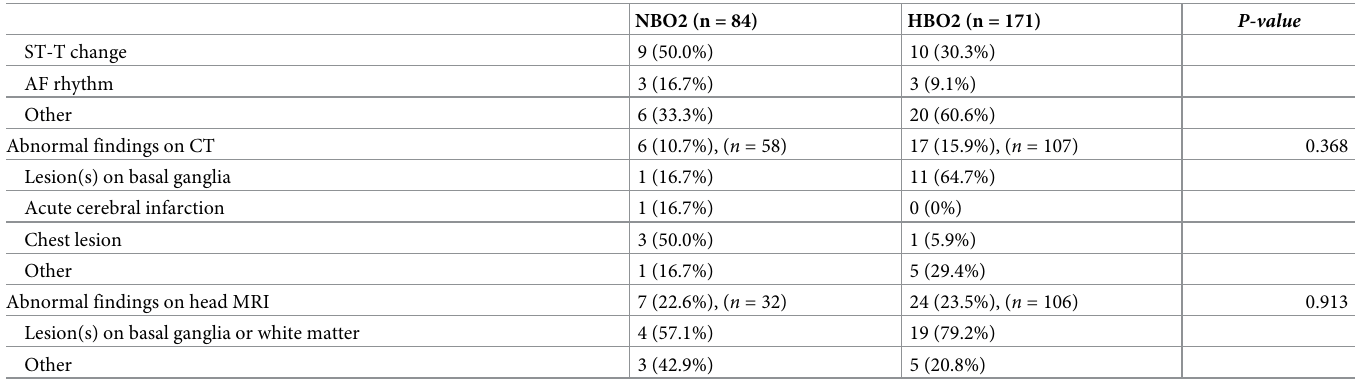
The treatment pressures in each HBO session during the first 24 h are shown in Table 2. 2 The treatment pressure in the first HBO session was 2.8 atmospheres absolute (ATA) (47.9% 2 of the HBO group), 2.0 ATA (41.8%), 2.5 ATA (7.9%), or another pressure (2.4%). A treat- 2 ment pressure of 2.0 ATA was used in the majority of patients in both the second and third HBO sessions. In addition, HBO therapy were not administered during the first 24 h in 2 2 2 patients of the HBO group and the details of HBO therapy were unknown in 4 patents. 2 2 The number of patients treated with mechanical ventilation was significantly more in the NBO group than in the HBO group (25.0% vs 4.7%, respectively, P < 0.001; Table 3). The 2 2 period of oxygen administration during the hospital stay was 344 ± 2128 h and 70 ± 190 h in the NBO and HBO groups, respectively, which did not differ significantly ( P = 0.266; 2 2 Table 3). ICU days was also significantly longer in the NBO group than in the HBO groups 2 2 (4.1 ± 11.0 and 1.3 ± 2.4 days, respectively; P = 0.025; Table 3), but hospital days did not differ between the groups ( P = 0.294; Table 3).